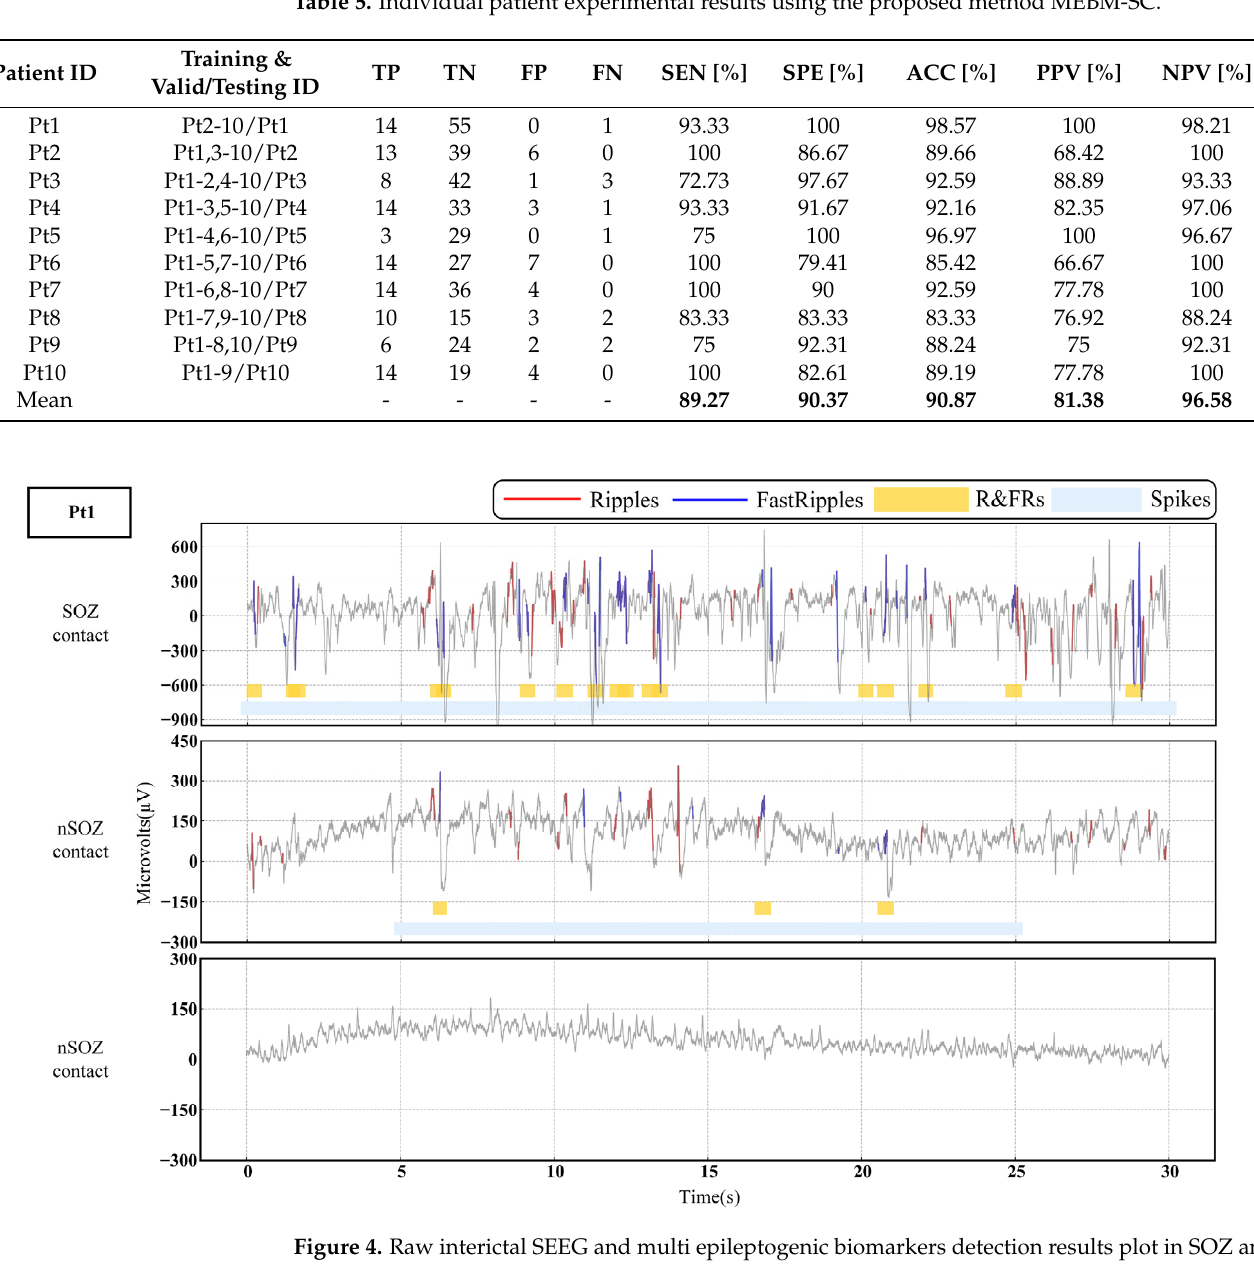
Table 5. Individual patient experimental results using the proposed method MEBM-SC.